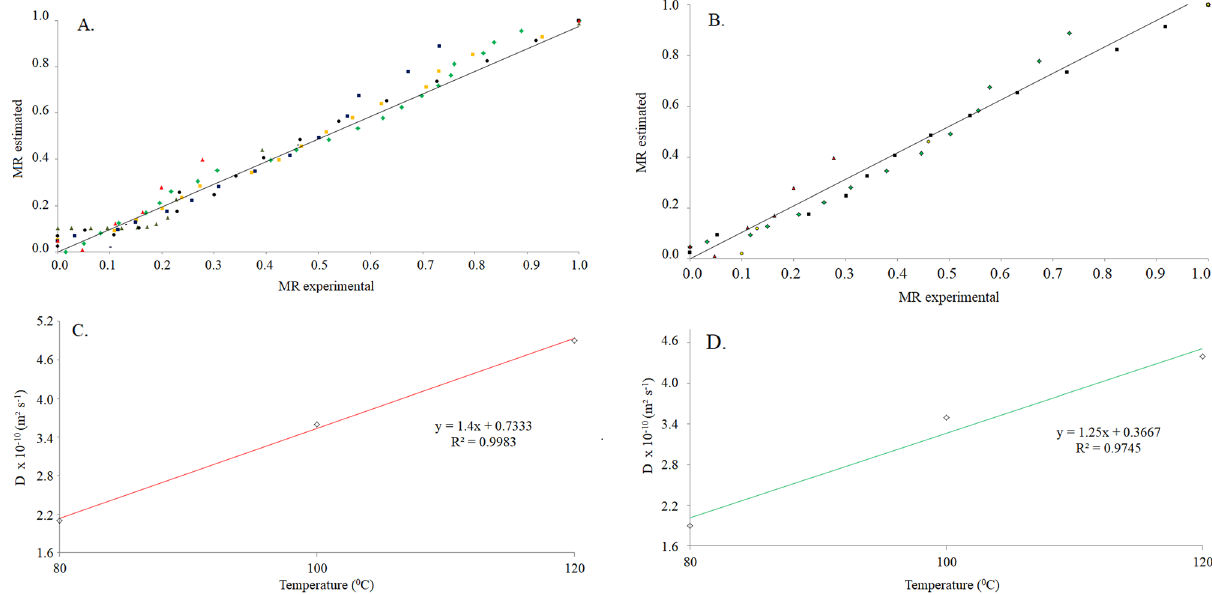
Figure 3. Ratio of experimental values and estimated by the Wang & Singh model at initial moisture content of 23% (d.b.) ( A ), and at initial moisture content of 18% (d.b.) ( B ), effective diffusion coefficient (m 2 s −1 ) for 23% (d.b.) of the initial moisture content in the grains ( C ), effective diffusion coefficient (m 2 s −1 ) for 18% (d.b.) of the initial moisture content in the grains ( D